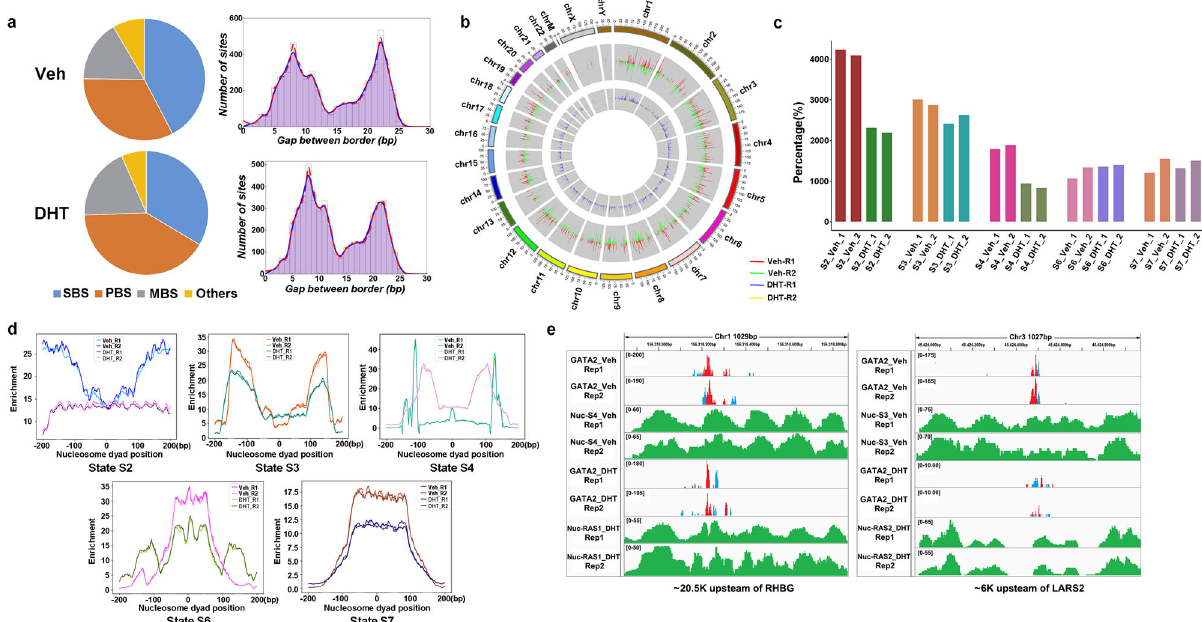
Fig. 4 GATA2-associated functional nucleosome states in Veh and DHT-treated conditions. a Identi fi cation of GATA2 borders and a distribution of gaps between borders showing a bimodal pattern for each of two biological replicates. b GATA2 border distribution within different chromosomes in the conditions of Veh and DHT treatment. c The number of GATA2 borders located on nucleosomes and distributed on different nucleosome states for each of two replicates. d An enrichment plot of GATA2 borders in different nucleosome states for each of two replicates. e Two screenshots showing the changes of GATA2 borders along with nucleosome states